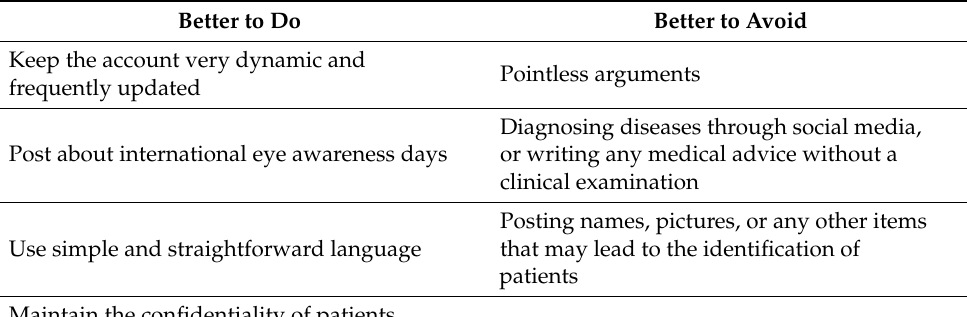
Table 5. Tips when using social